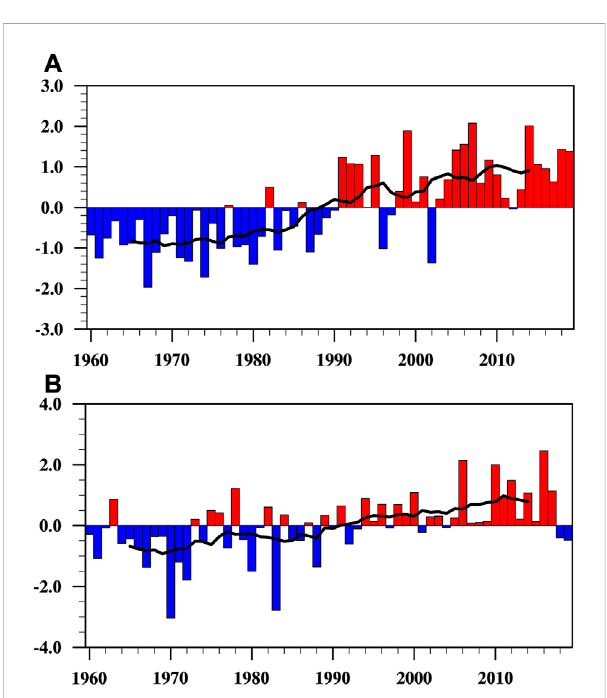
FIGURE 5 Thebarsindicatenormalizedtimeseriesof (A) CDDAindexinthe CESM-LE MME and (B) ZWI-LE during 1960 – 2019. The lines indicate 11-year running mean for the corresponding time